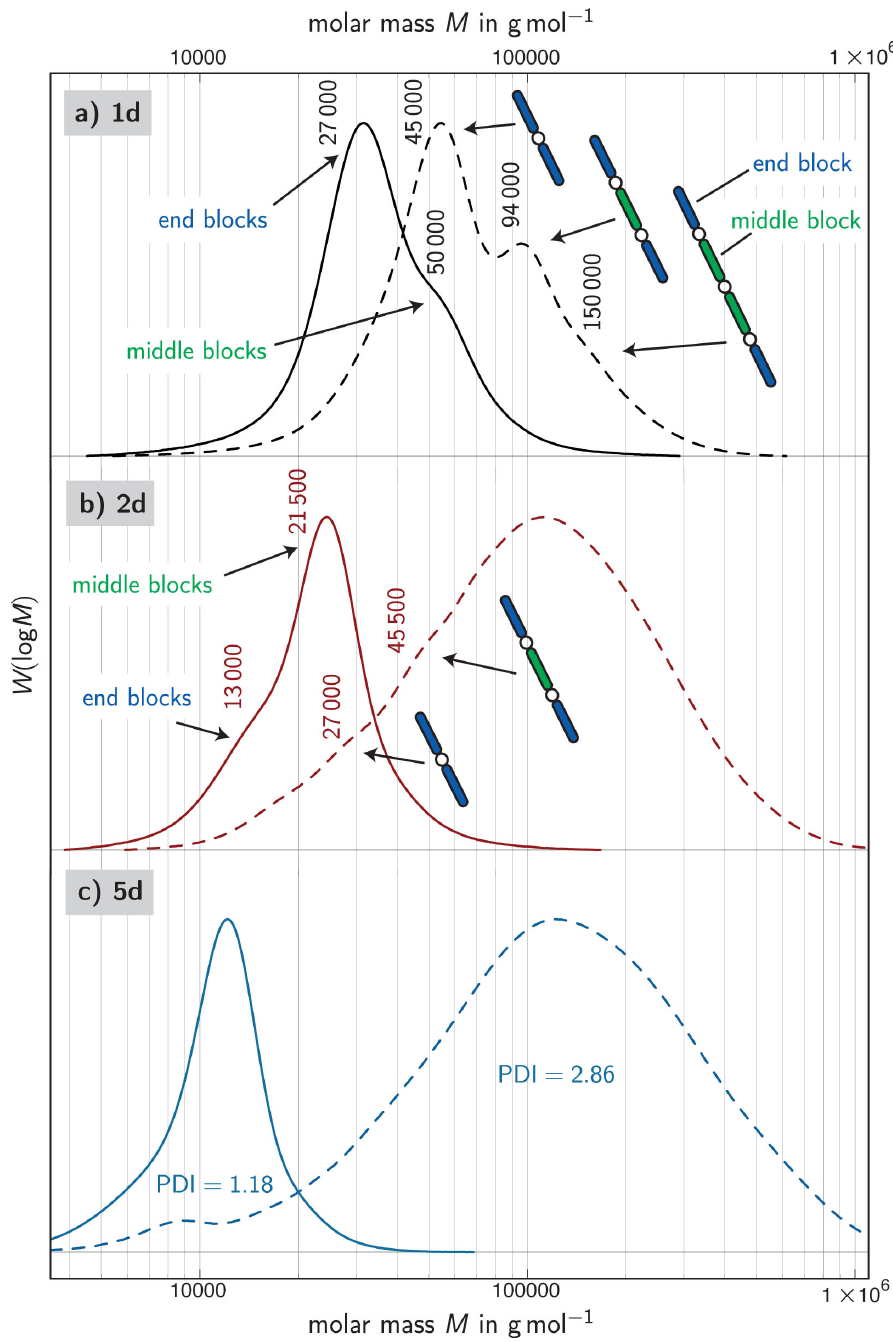
Figure 5. ( a ) SEC curves of polymer 1d before (dashed line) and after (solid line) aminolysis; ( b ) SEC curves of polymer 2d before (dashed line) and after (solid line) aminolysis. (The numbers in the diagrams indicate the maxima of the number-weighted distributions.); ( c ) SEC curves of polymer 5d before (dashed line) and after (solid line)